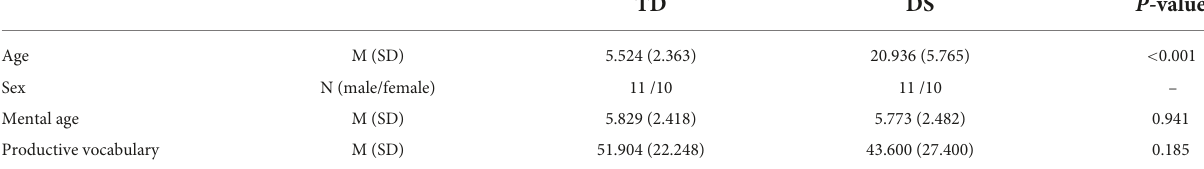
TABLE 1 Socio-demographic